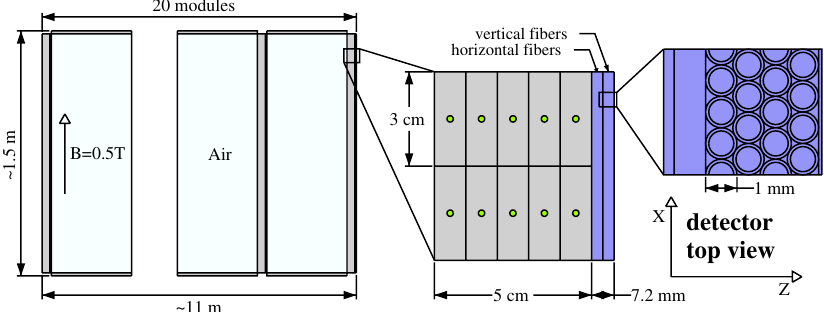
FIG. 6. Schematic drawing of the scintillating fiber tracker.